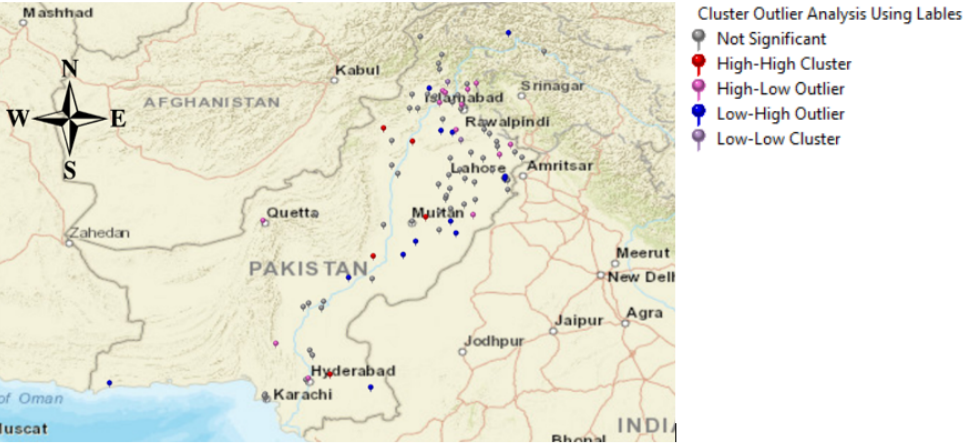
Figure 11. Visualization of cluster outlier analysis of tweets’ labels over Pakistan’s base map using Ar-